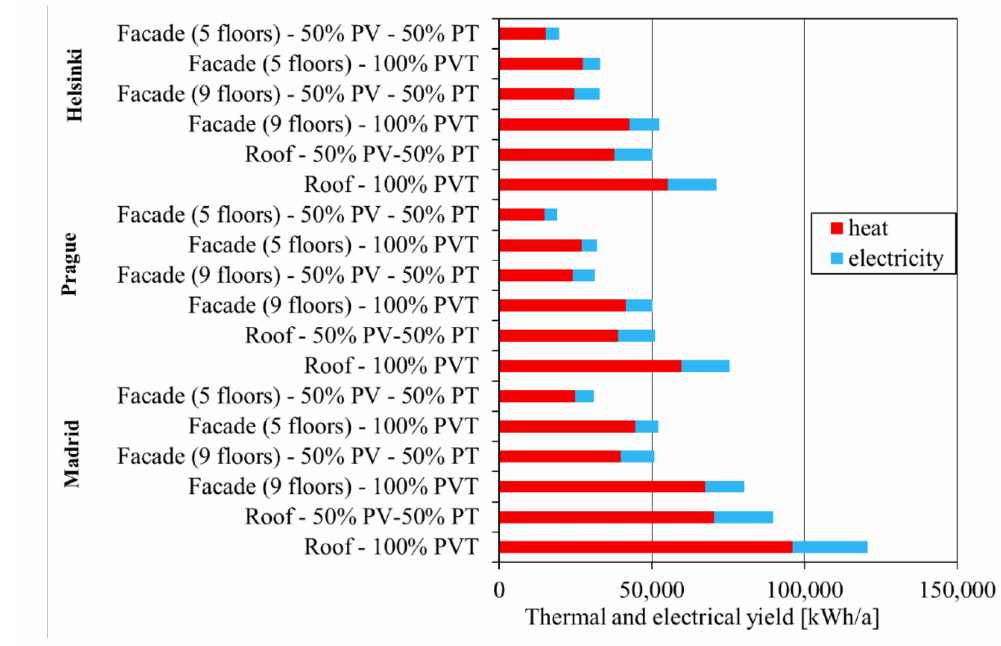
Figure 15. Thermal and electric yield for all the alternatives in three locations (reprinted from [94], with permission from